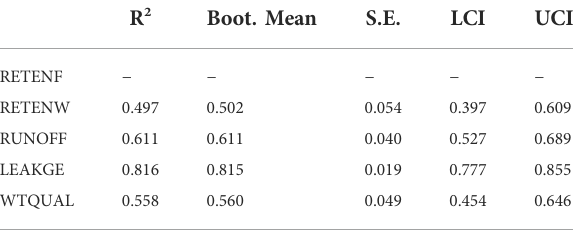
TABLE 8 Inner model fi ts. Coef fi cients of determination (R 2 ) representing how well variation in latent variable is described by all antecedent latent variables. Bootstrap standard error estimates (S.E.), and associated interquartile con fi dence intervals (LCI, UCI) are also presented. Note that RETENF does not have any antecedent latent